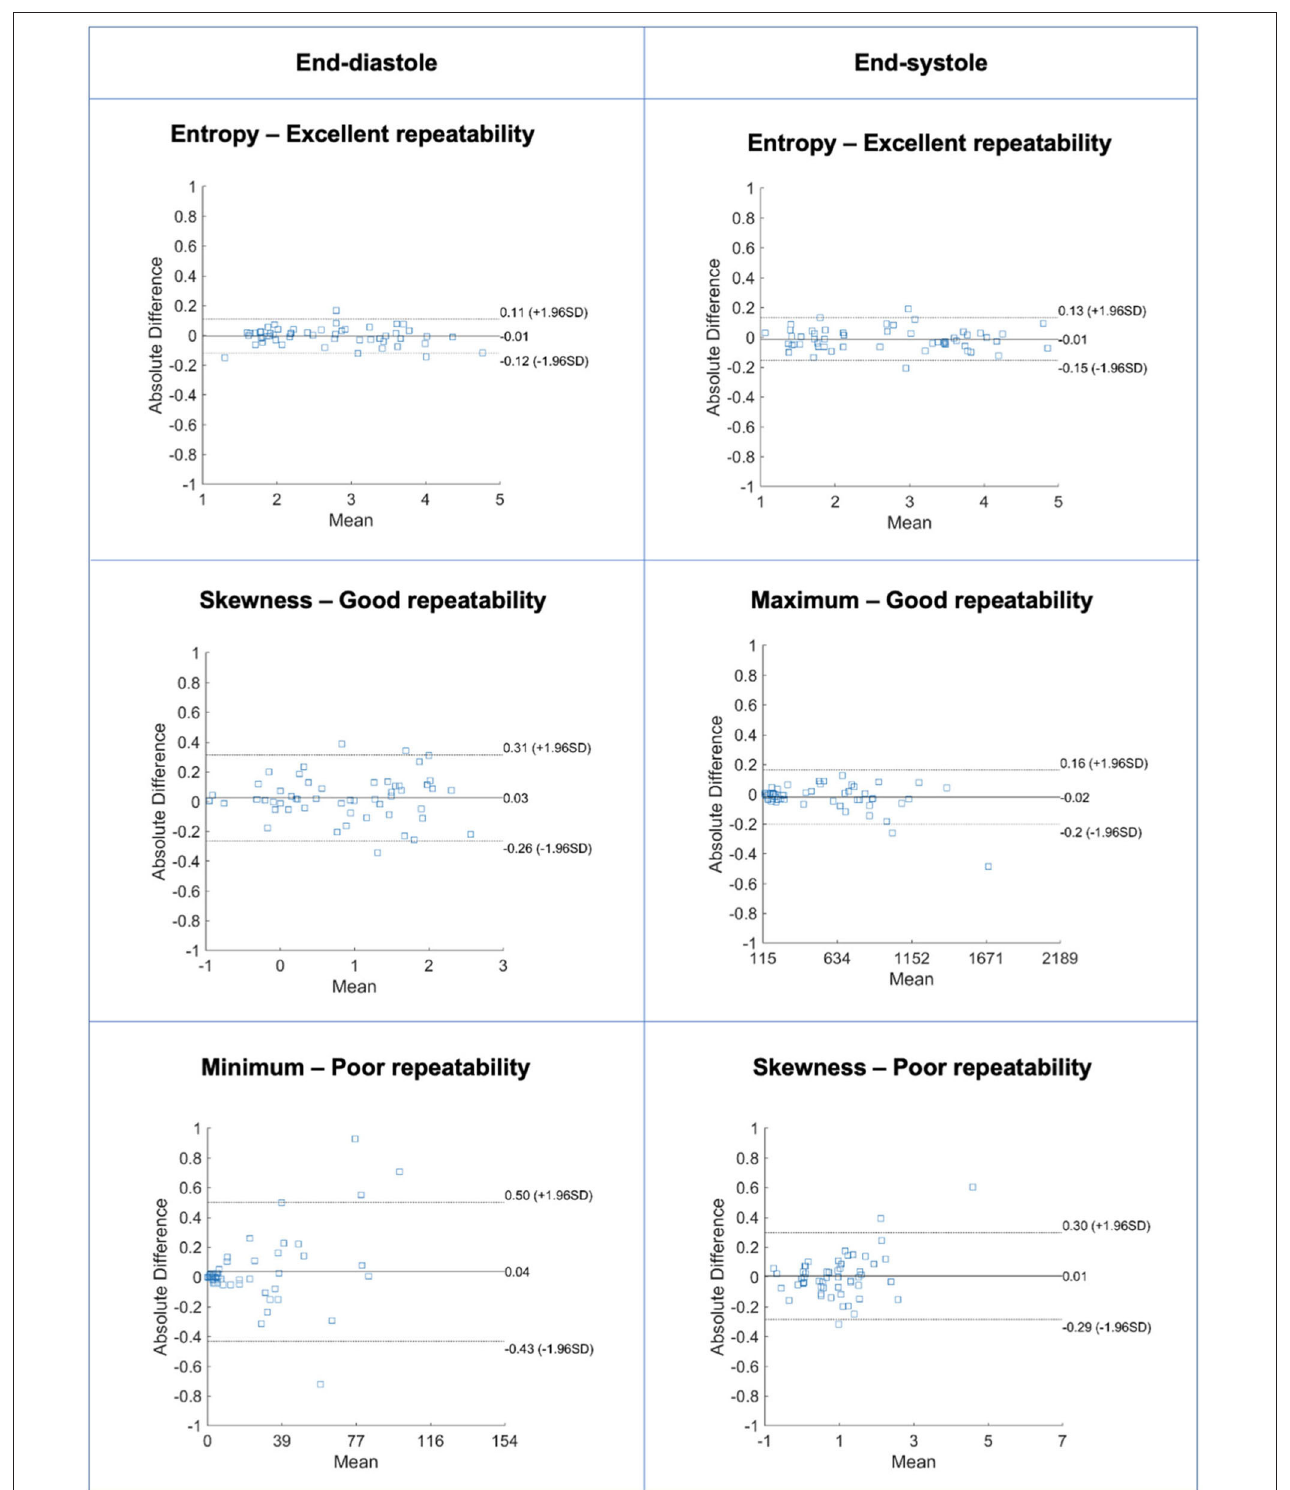
FIGURE 6 | Bland-Altman plots for selected LV myocardium first-order features in end-diastole (left) and end-systole (right) with different levels of repeatability. Differences in Bland-Altman are calculated after normalizing radiomics in the range [0–1] to facilitate comparison among different features. All features are unitless. LV: left